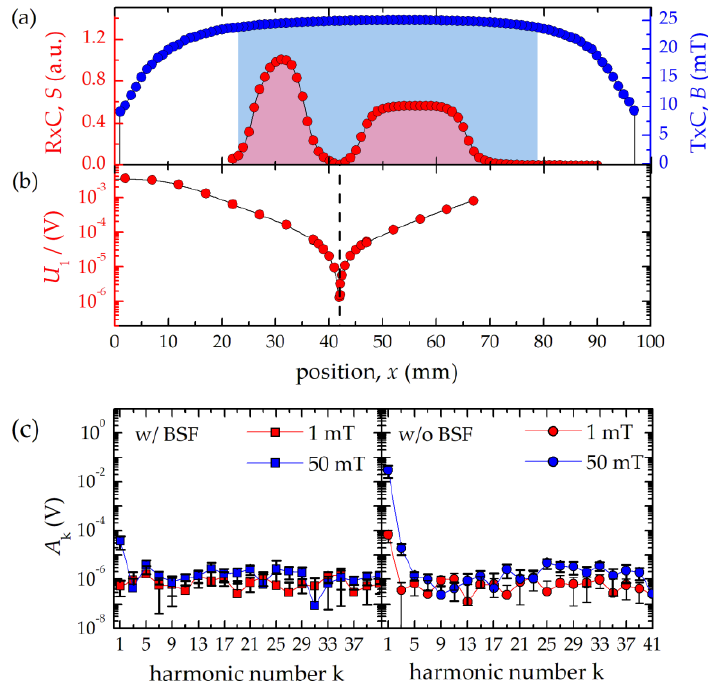
Figure 2. Signal acquisition and excitation cancellation with benchtop MPS device: ( a ) Axial excitation field profile (blue symbols) inside the TxC measured by a small probing coil (inner diameter: 1.5 mm, length: 1.7 mm, four layers, 68 turns). The range in which the excitation field deviates from the maximum value by less than 5% is highlighted in blue. The probing coil was further used to generate a reference signal to determine the sensitivity profile of the receive coil (red). ( b ) Measured induced voltage (1st harmonic) at different positions of the RxC within the TxC. ( c ) Measured spectrum of an empty flow cell (averaging 0.2 s, with background correction) at 1 mT (red symbols) and 50 mT (blue symbols) excitation field strength with (left, squares) and without (right, circles) BSF. Note, the connecting lines are a guide to the eye.